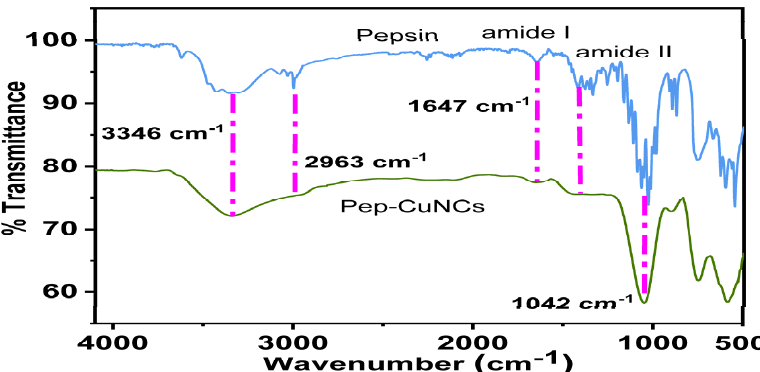
Figure 3. (blue) FTIR spectra of pepsin. (green) Pep-CuNCs.